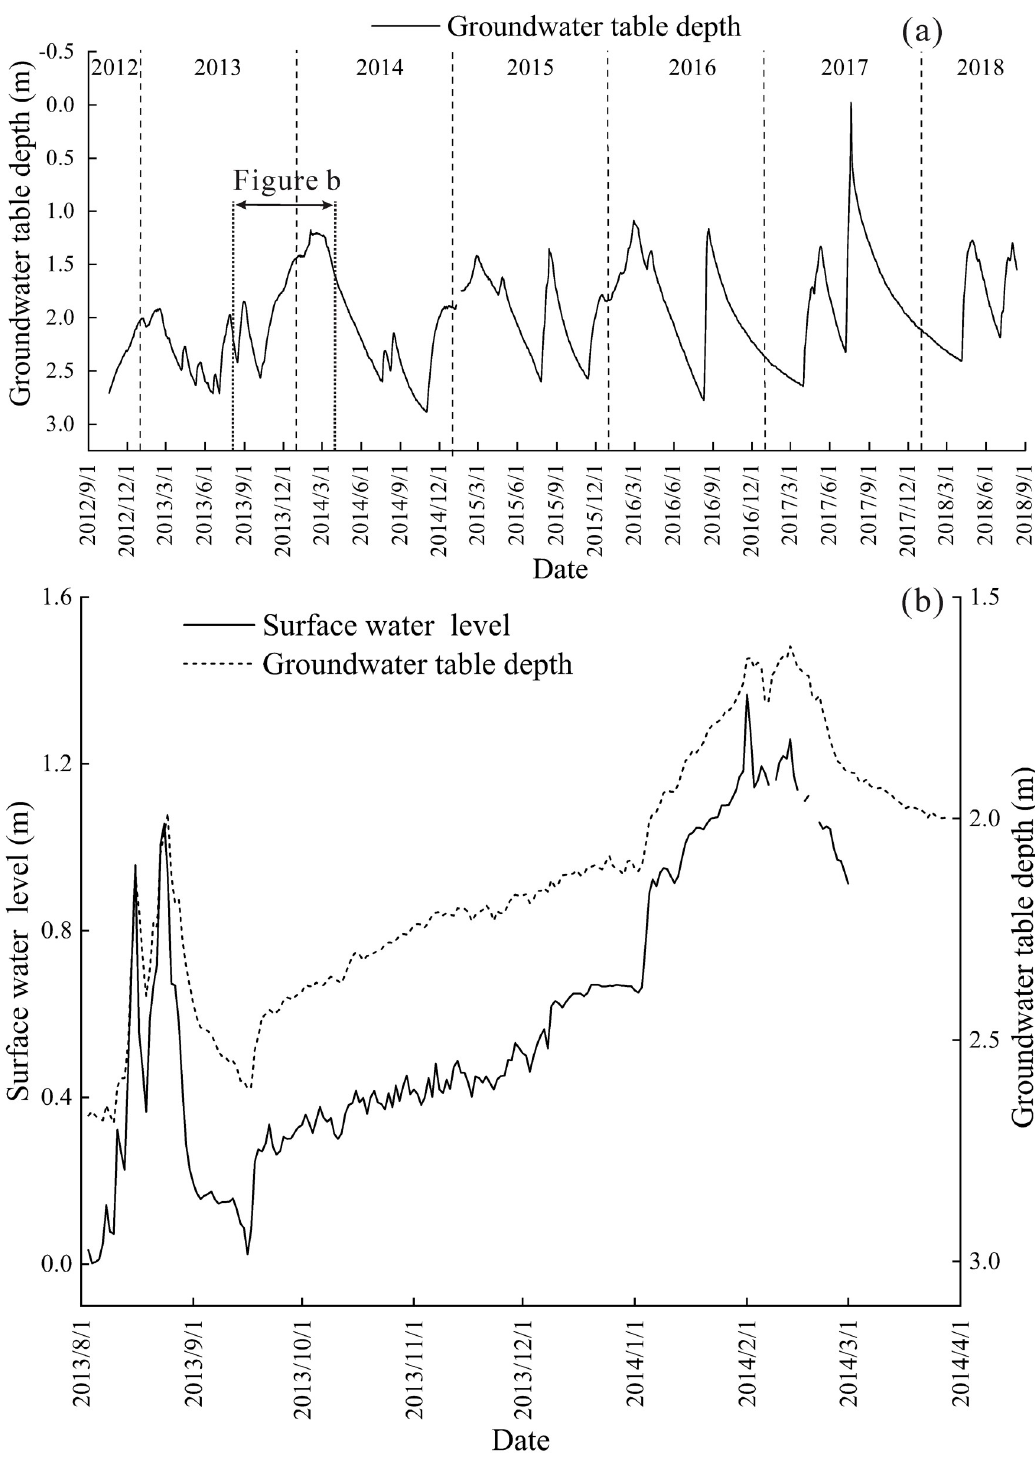
Fig 13. (a) Dynamic variation in the depth to the groundwater table in the monitoring well in Daliyaboyi oasis (based on data from 2012 to 2018); (b) Dynamic variation of the surface water level and groundwater table depth in the monitoring well in the upstream section of the lower reach (based on data from 2013 to 2014) [80,